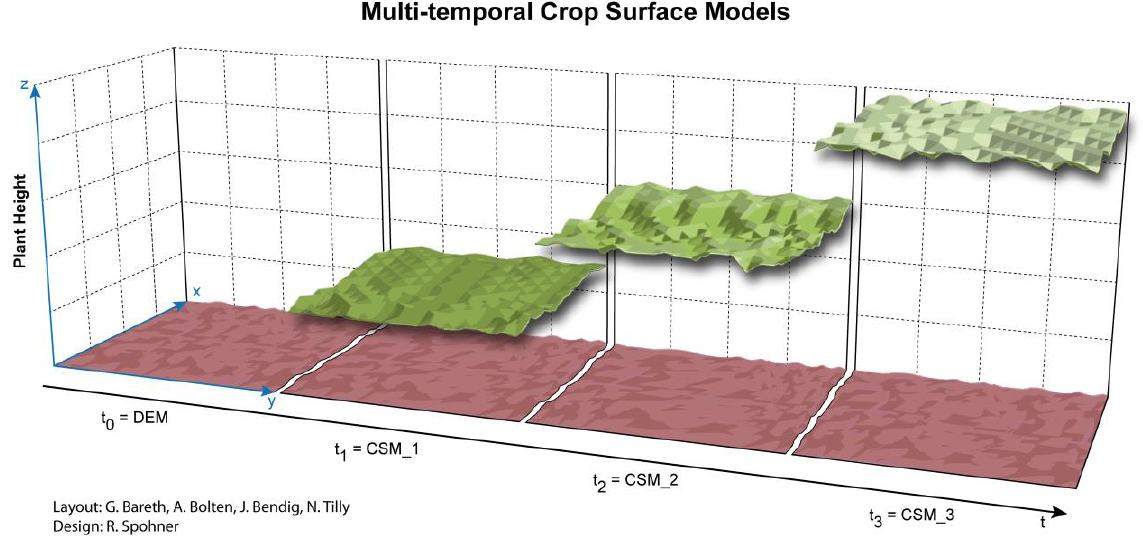
Figure 1. General concept for the construction of multi-temporal crop surface models